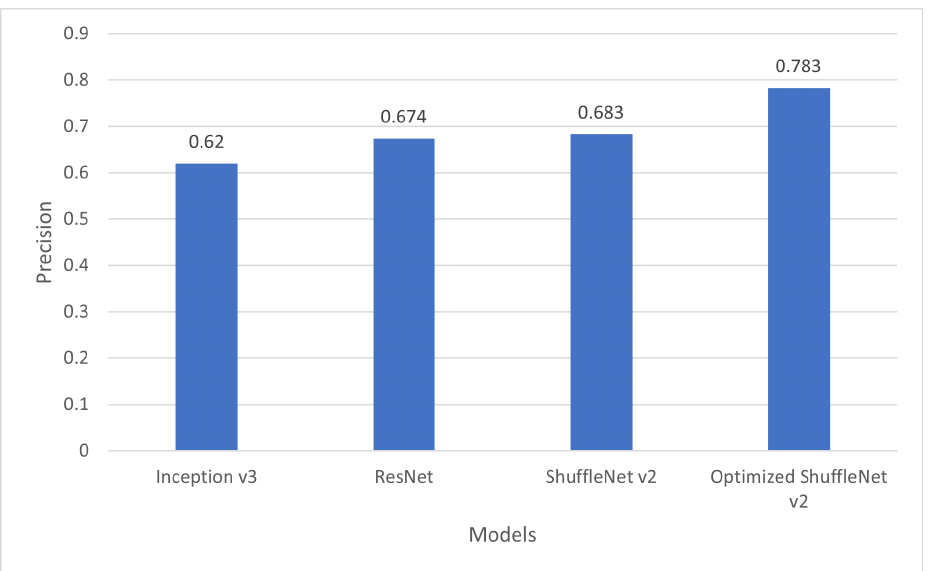
Figure 6. Classification precision of different models.